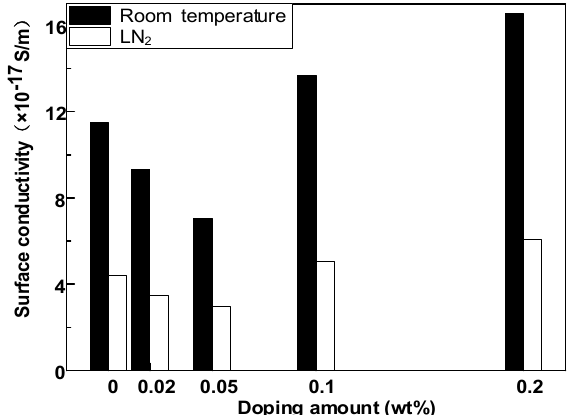
Figure 3. Surface conductivity of epoxy resin–GO composites.